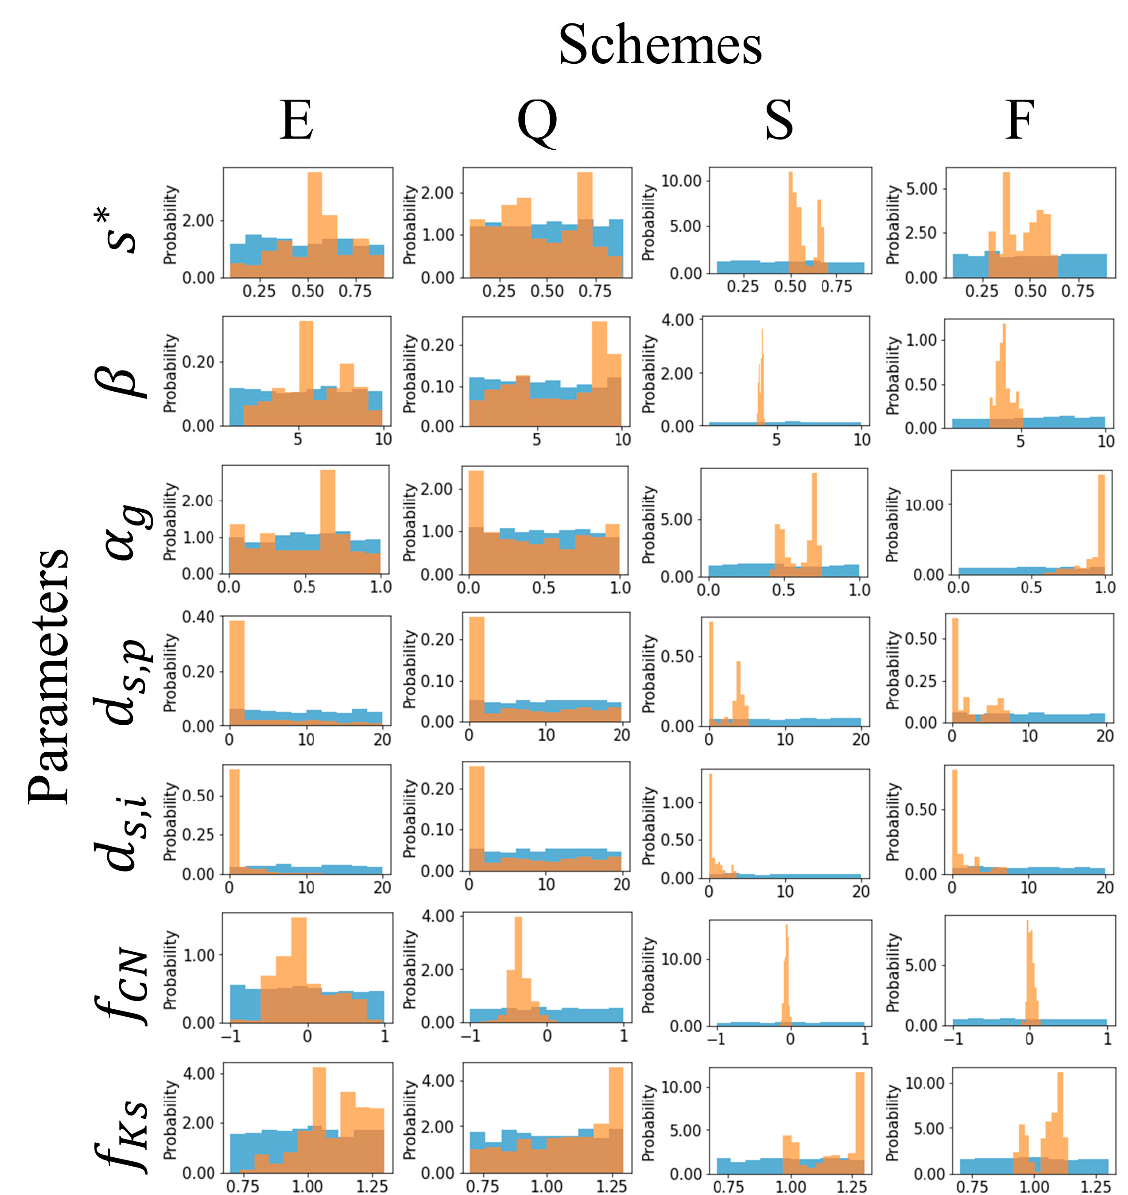
Figure 3. Estimated prior distribution (blue colour) and posterior distribution (orange colour) of parameters by each calibration scheme for Hapcheon dam watershed calibrated using 2016–2017 data ( HCD A ).